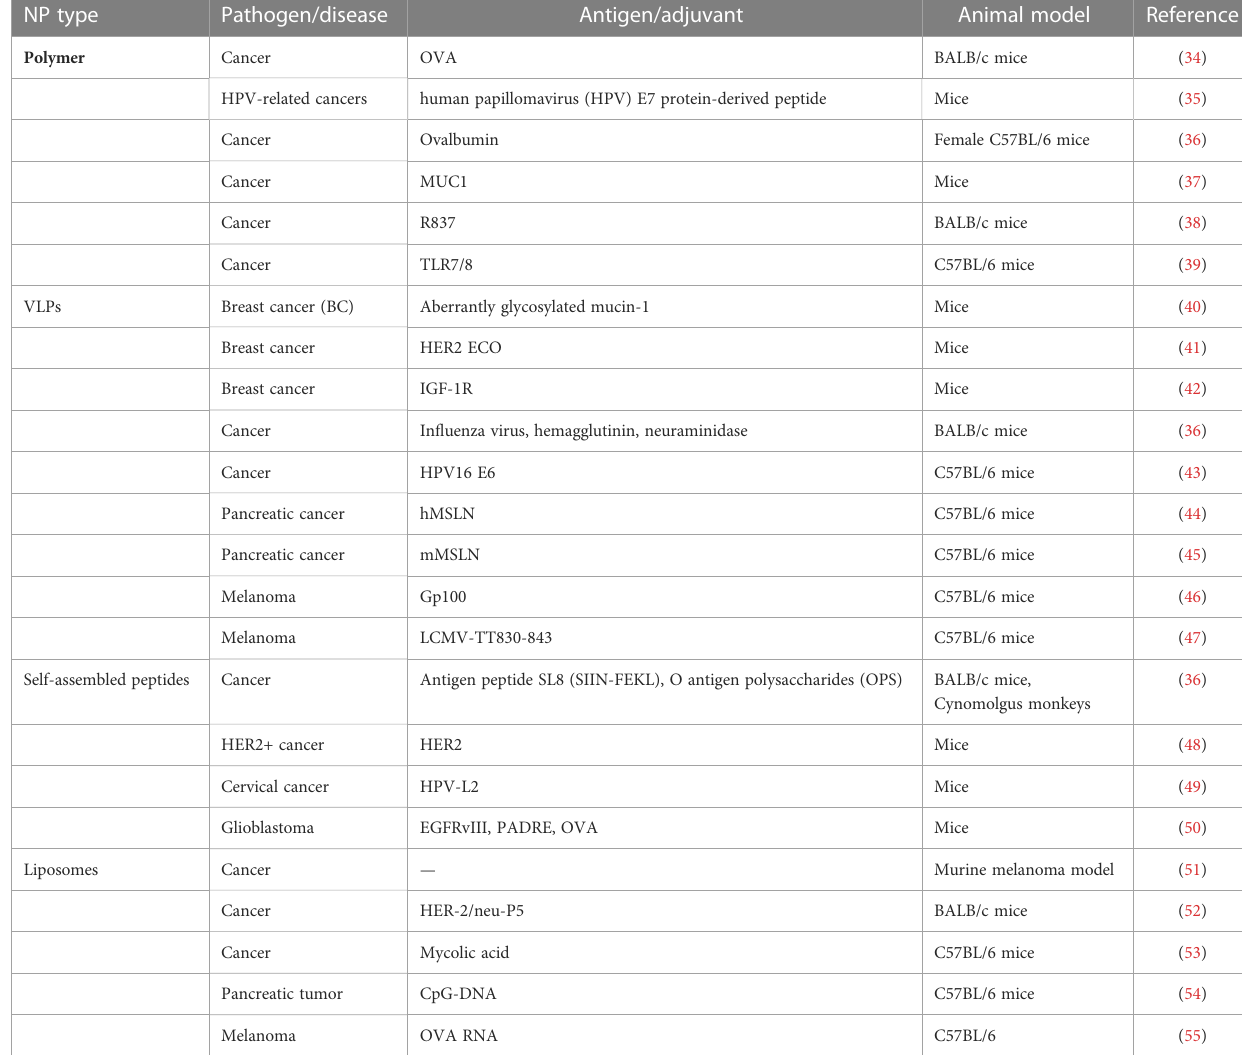
TABLE 1 Summary of SANPs that have been explored as delivery platforms for